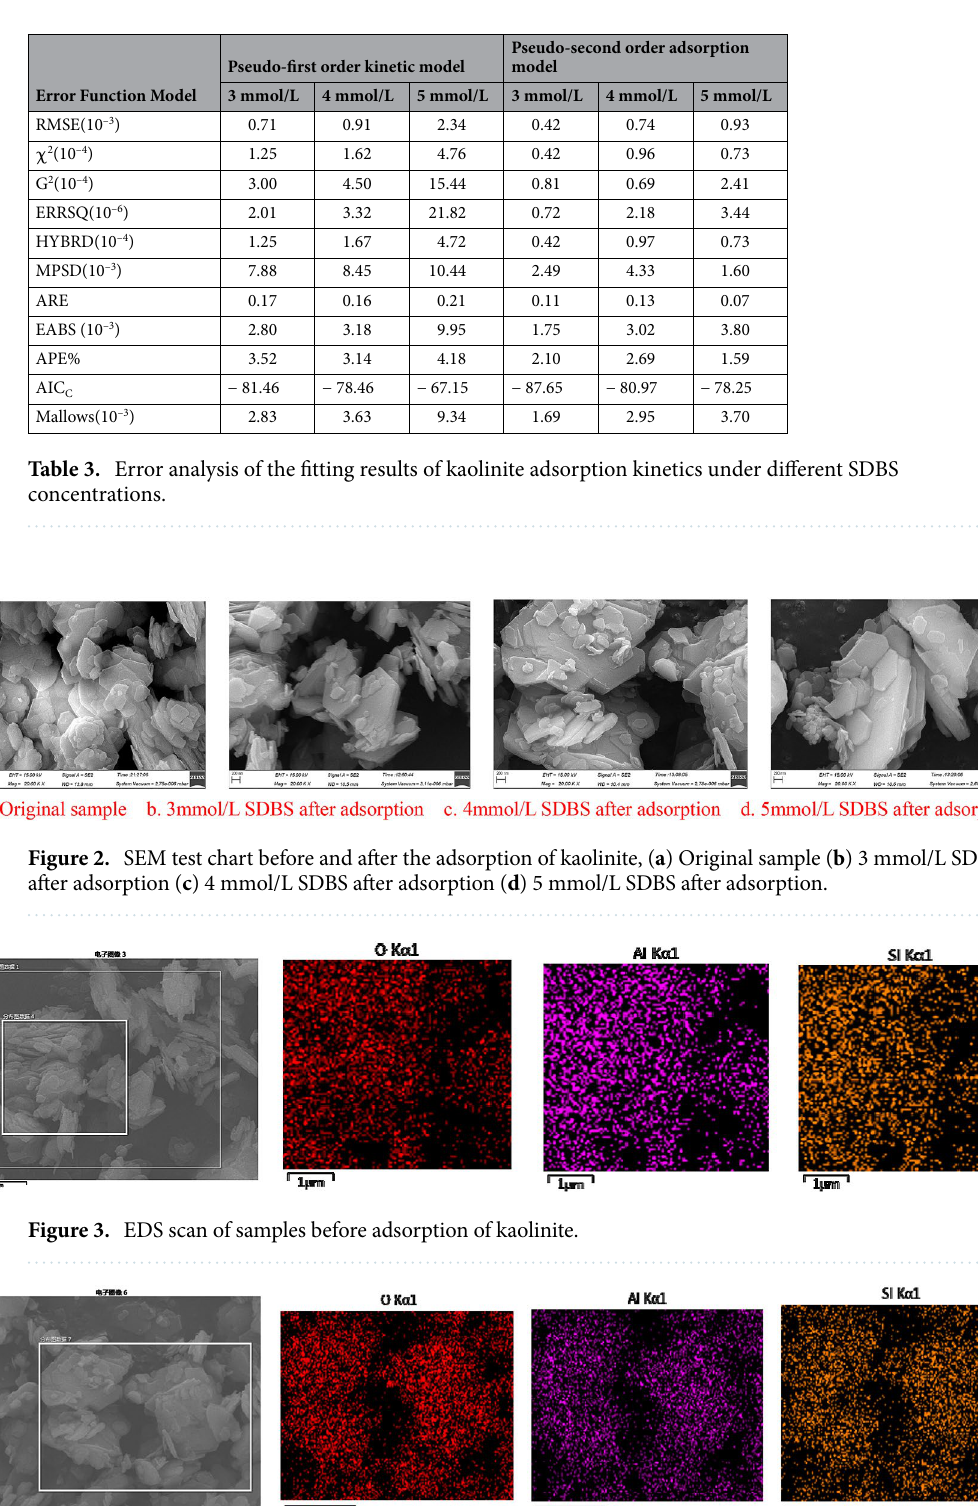
Figure 4. EDS scan of kaolinite after the adsorption of 4 mmol/L